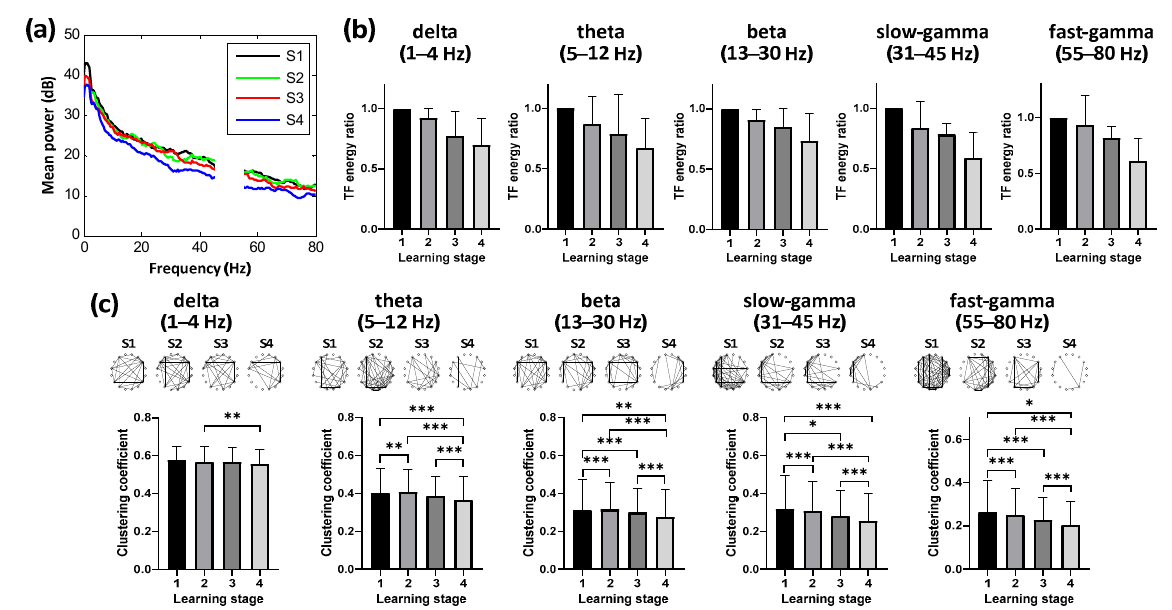
Figure 4. Dynamic neural patterns in NCL during learning ( n = 6 animals, 16 sessions ) . ( a ) Power spectral density in NCL during route formation of spatial learning. ( b ) Mean time–frequency (TF) energy changes in different bands relative to stage 1 for NCL. Data are presented as mean ± std. ( c ) Binarized functional networks for NCL (Top, examples of the pigeon numbered P100) and statistical clustering coefficient results of the networks (Bottom, population data of all pigeons) for different bands across learning stages (* p < 0.05, ** p < 0.01, *** p < 0.001; Friedman ANOVA). Data are presented as mean ± std. S1 represents the learning stage 1, and so forth.